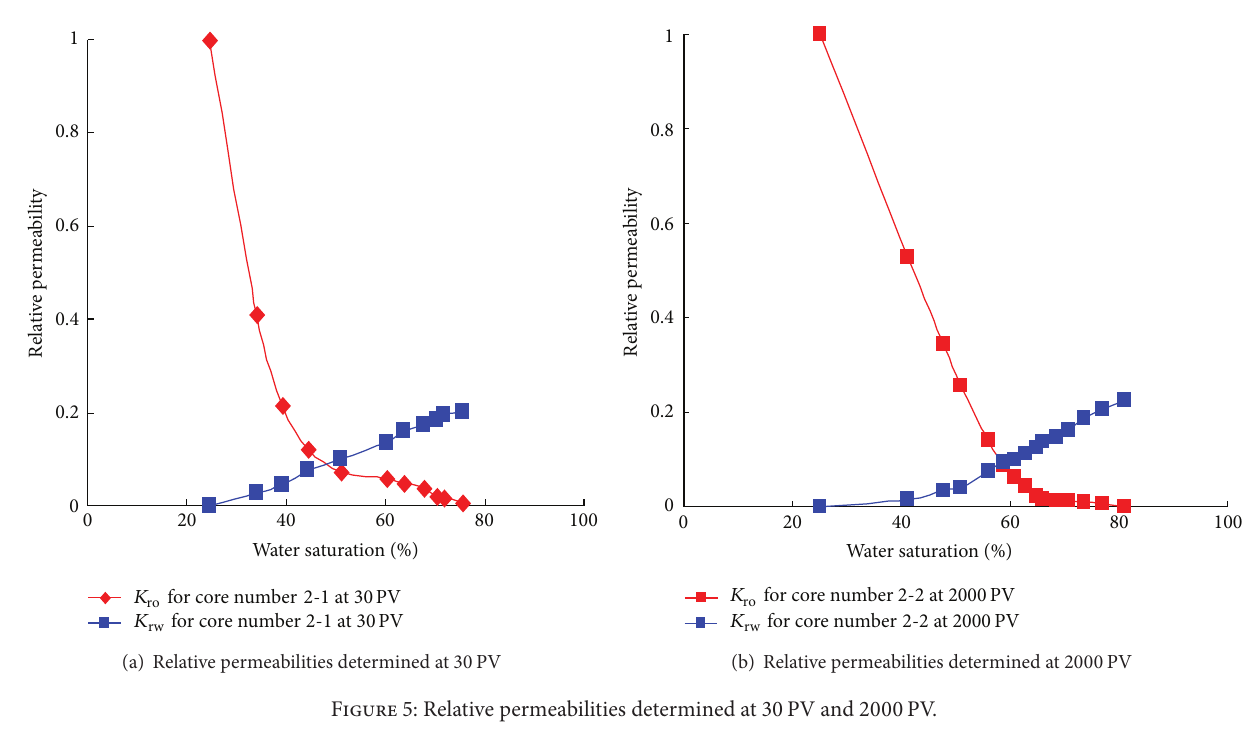
Figure 5: Relative permeabilities determined at 30 PV and 2000 PV.